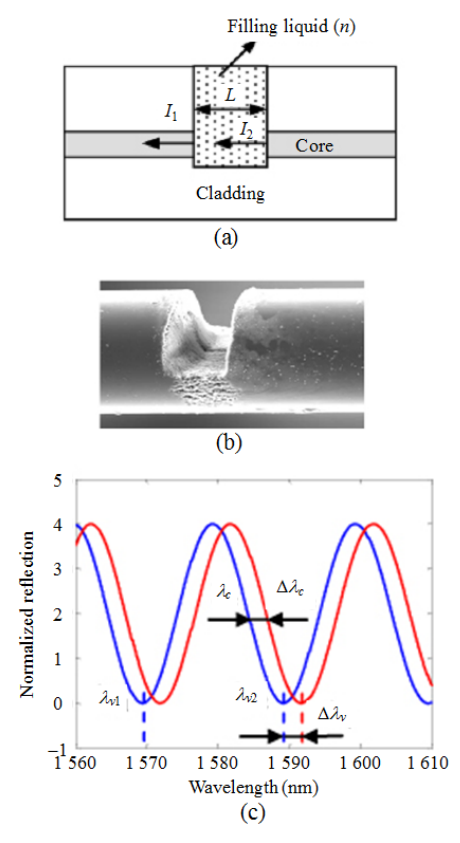
Fig. 19 Fiber inline FPI fabricated by fs laser micromachining: (a) structural schematic, (b) SEM image, and (c) simulated interference